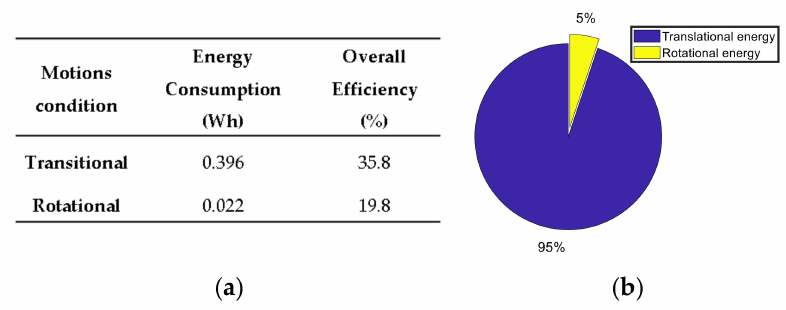
Figure 11. ( a ) Comparison of the transitional and rotational movement using experimental data. ( b ) Percentage of consumed energy for transitional and rotational